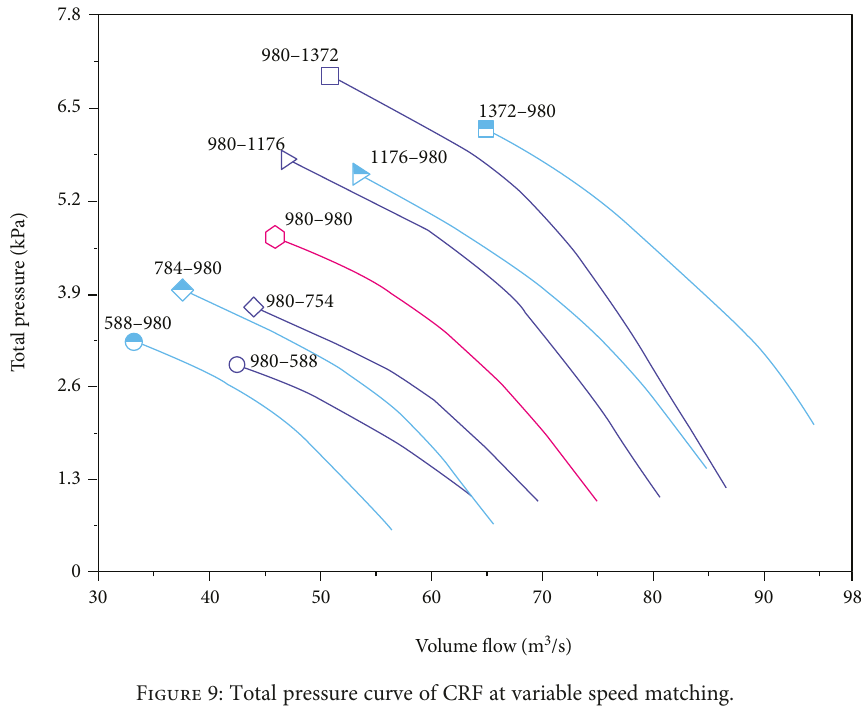
Figure 9: Total pressure curve of CRF at variable speed matching.